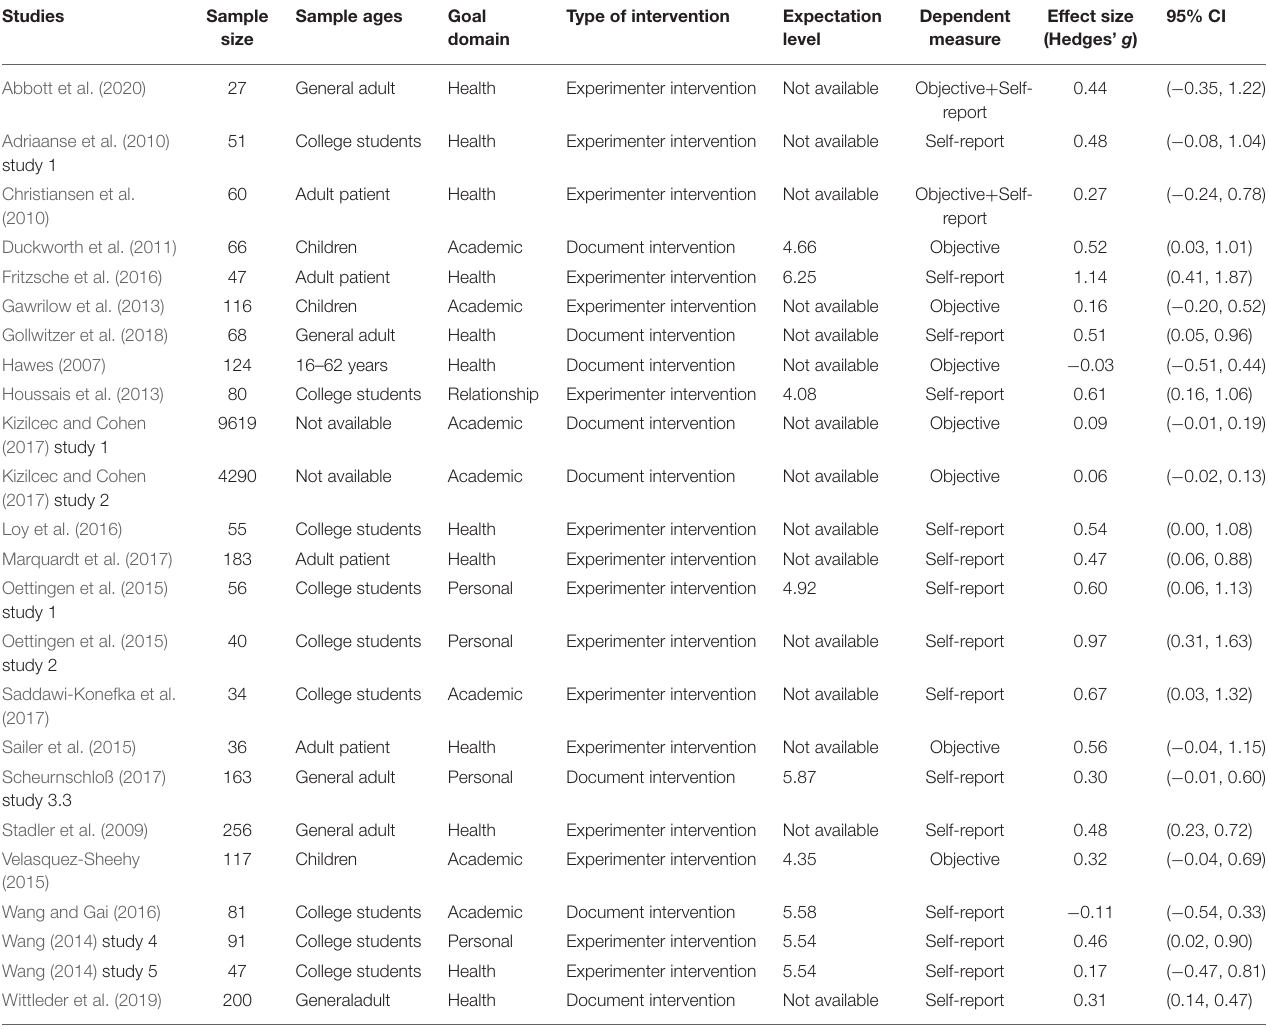
TABLE 1 | Studies included in the meta-analysis: effect size and study